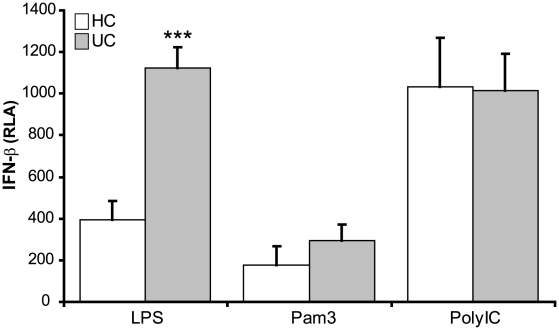
TLR4 activation results in an elevation in TRIF signaling and subsequent IFN-β release by macrophage from UC patients.Macrophages from UC (n = 11) and HC (n = 7) were stimulated for 6 h with rLPS (TLR4), Pam3CSK4 (TLR2/1) or Poly I:C (TLR3) and the levels of IFN-β release in determined. Results are expressed as relative luciferase activity (RLA) (mean ± SEM, ***p<0.001).